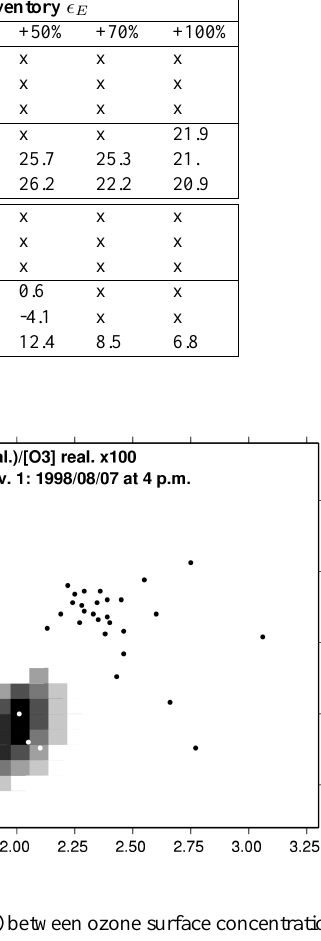
Fig. 7. Differences (ppb) between ozone surface concentrations ob- tained with the true emission inventory and with the first-guess in- ventory +100% at 4 p.m. The average difference with true emissions is roughly de- creased by 45.1 to 59.3% (and increased for one case) with measurements alone and by 26.8 to 31.6% with kriging. Nev- ertheless, the higher variances of the m-cases (9.9 to 121.4% compared to less than 9% with kriging, see Table 1) indicate that with measurements alone, the corrections of the fluxes are not well distributed, neither in space nor in time.